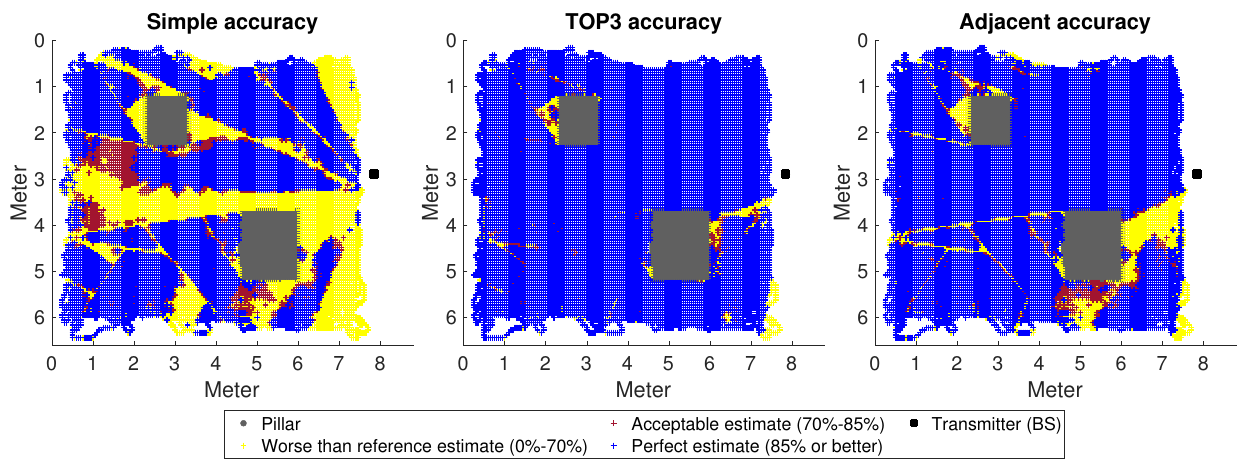
Figure 5. A movement of 5,000,000 steps in Room A1; the accuracy interpreted according to the metrics is presented. The areas marked in white were not visited during the test.